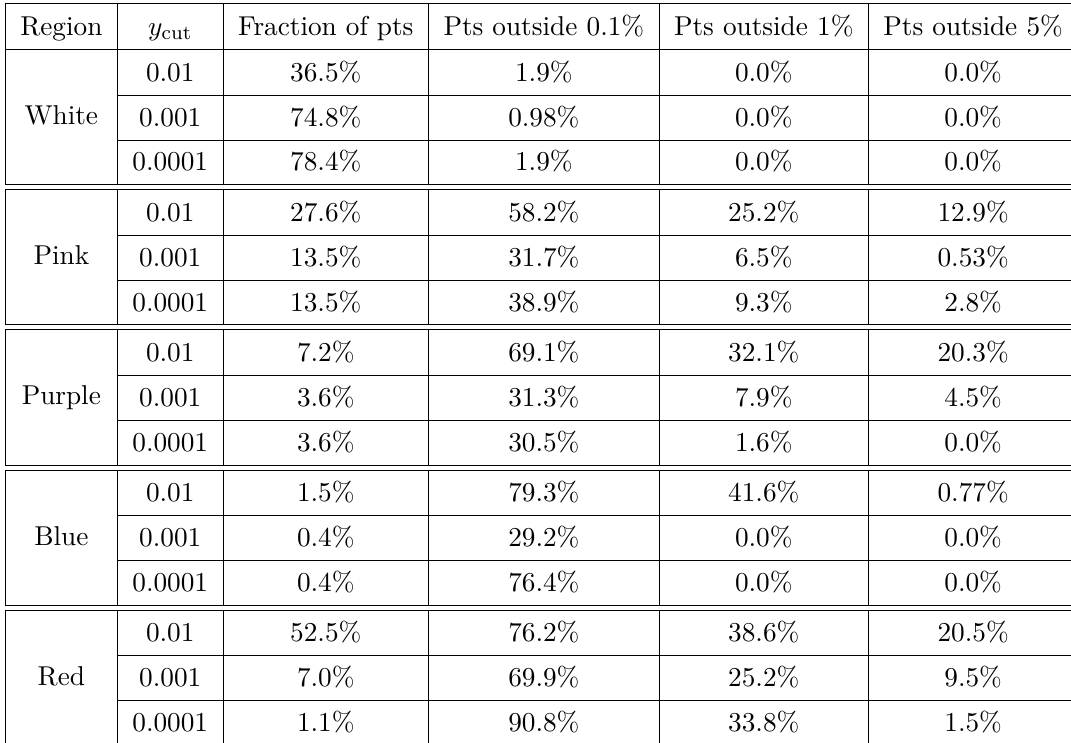
Table 2 . The performance of trajectory predictions separated for white, pink, purple, blue, and red regions. We present the percentage of points that lie outside 0.1%/1.0%/5.0% errors. Fraction of points indicates the percentage of points that lie in the region of interest, out of all phase-space points from the 50 trajectories we